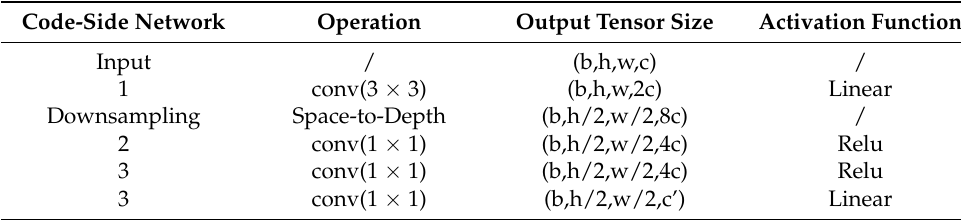
Table 1. Hyper analysis transform.